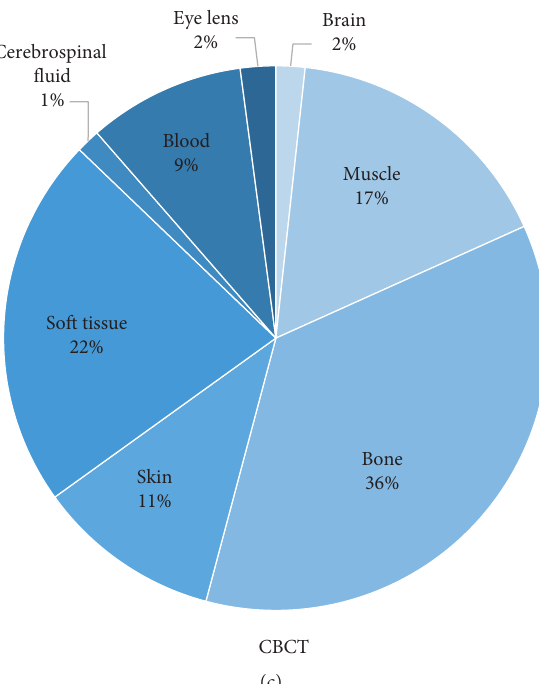
Figure 3: Percent fraction of radiation dose for the different tissues in the head derived from the MC-GPU simulation of the human head phantom exposed to (a) intraoral radiography, (b) panoramic radiography, and (c) cone-beam computed